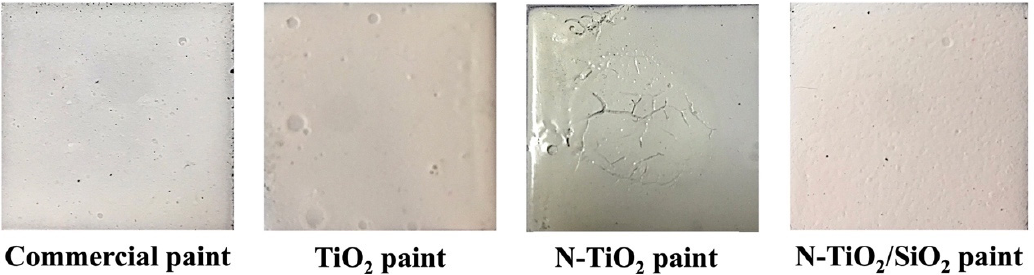
Figure 6. The acid resistance tests of commercial paint (without photocatalyst), TiO 2 paint, N-TiO 2 paint, and N-TiO 2 @SiO 2 paint .